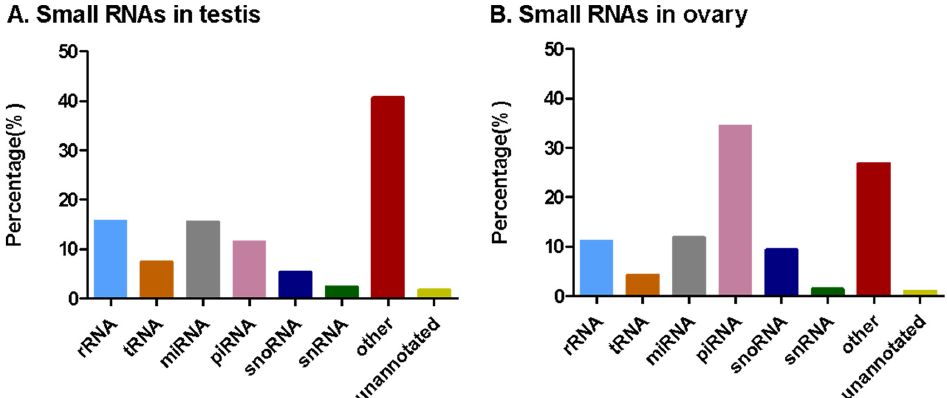
Figure 3. Composition of different types of small RNAs in the testes ( A ) and ovaries ( B ) of 0-day-old males and 2-day-old female adults of H. armigera . Small RNAs were annotated by the Blast search against the Rfam and piRBase databases. The range length for small RNAs is 15–50 bp.